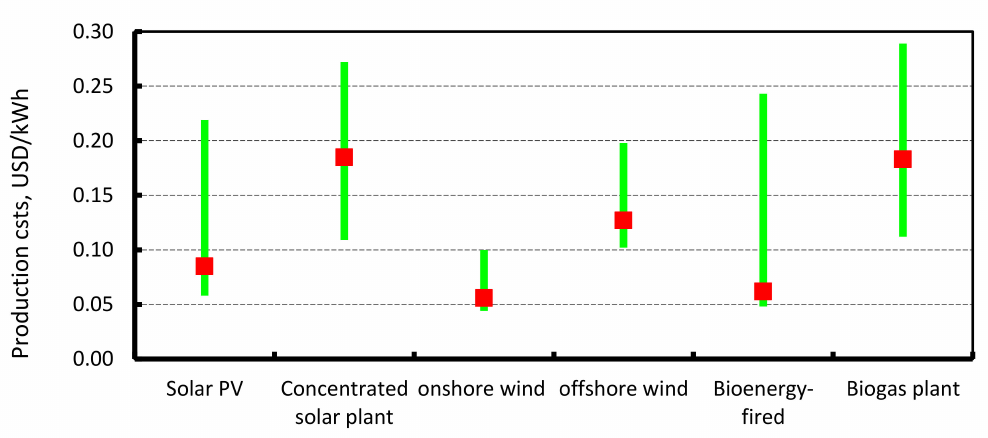
Figure 8. Electricity production costs from renewable